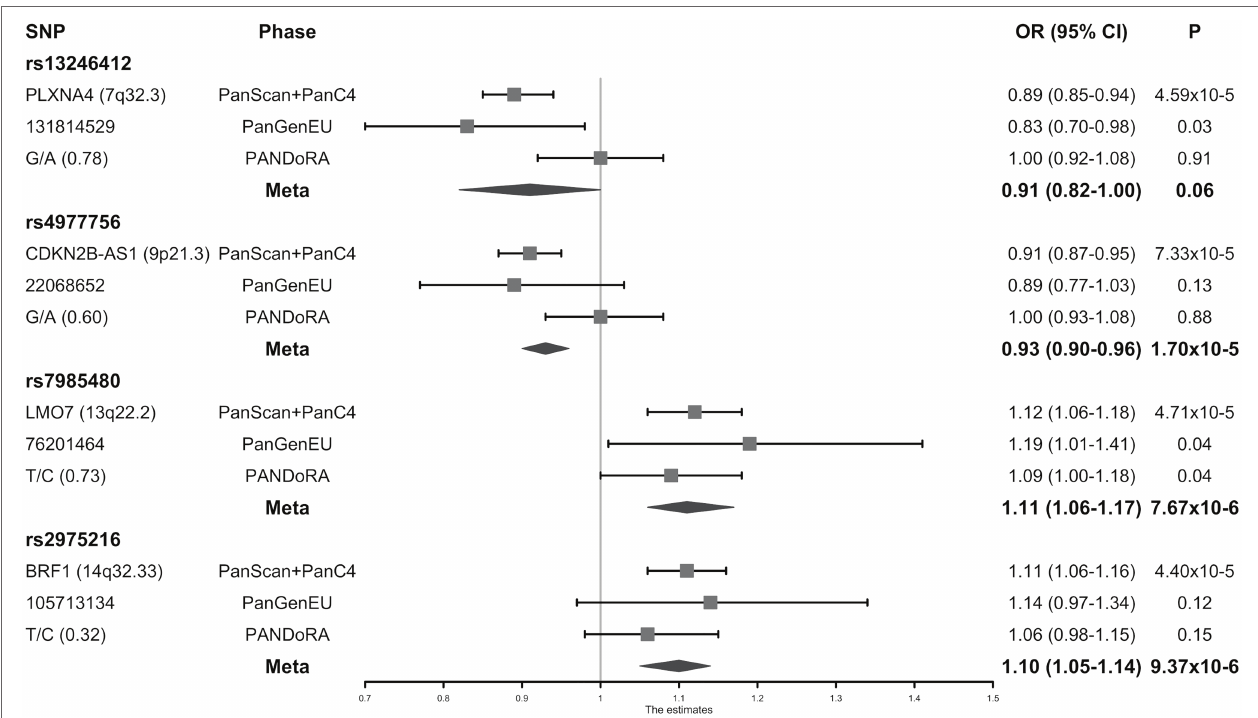
FIGURE 2 | Forest plot of the associations between the four micro-RNA (miRNA)-related single nucleotide polymorphisms (SNPs) and the risk of pancreatic cancer